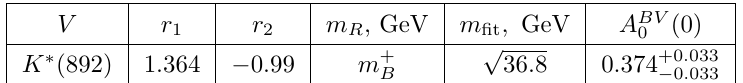
Table 10 . Values of the parameters in the vector form-factor (F.20) from [49].